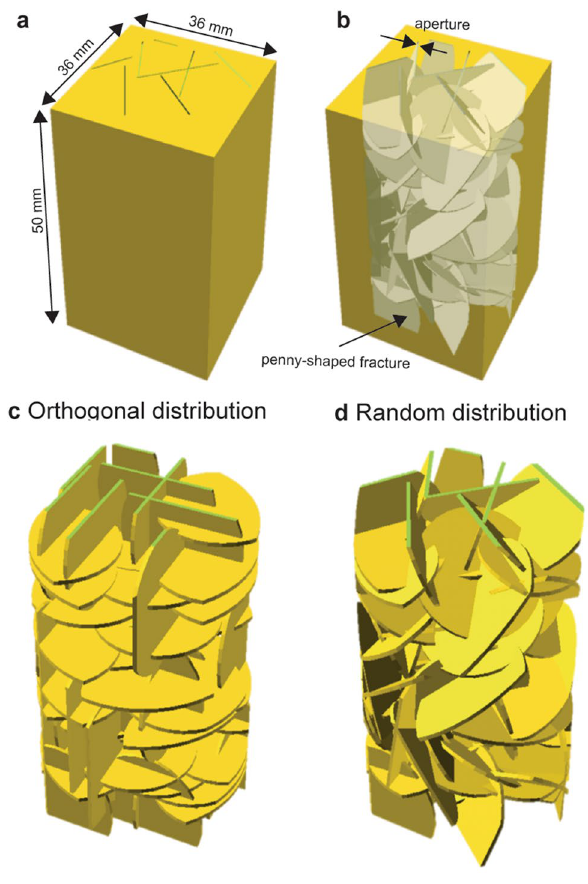
Figure 3. Fractured models. ( a ) Outside and ( b ) inside of model. ( c ) Orthogonal distribution and ( d ) random distribution of fracture